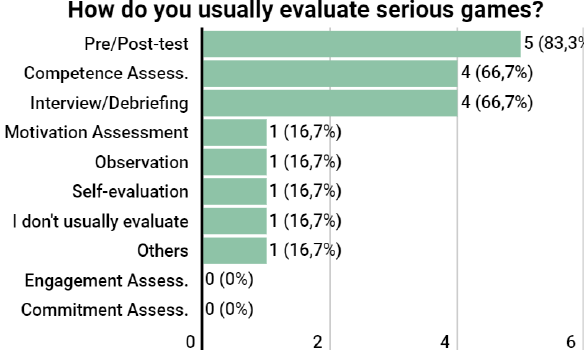
Figure 7. Types of assessment/evaluation objectives and techniques used by experts in